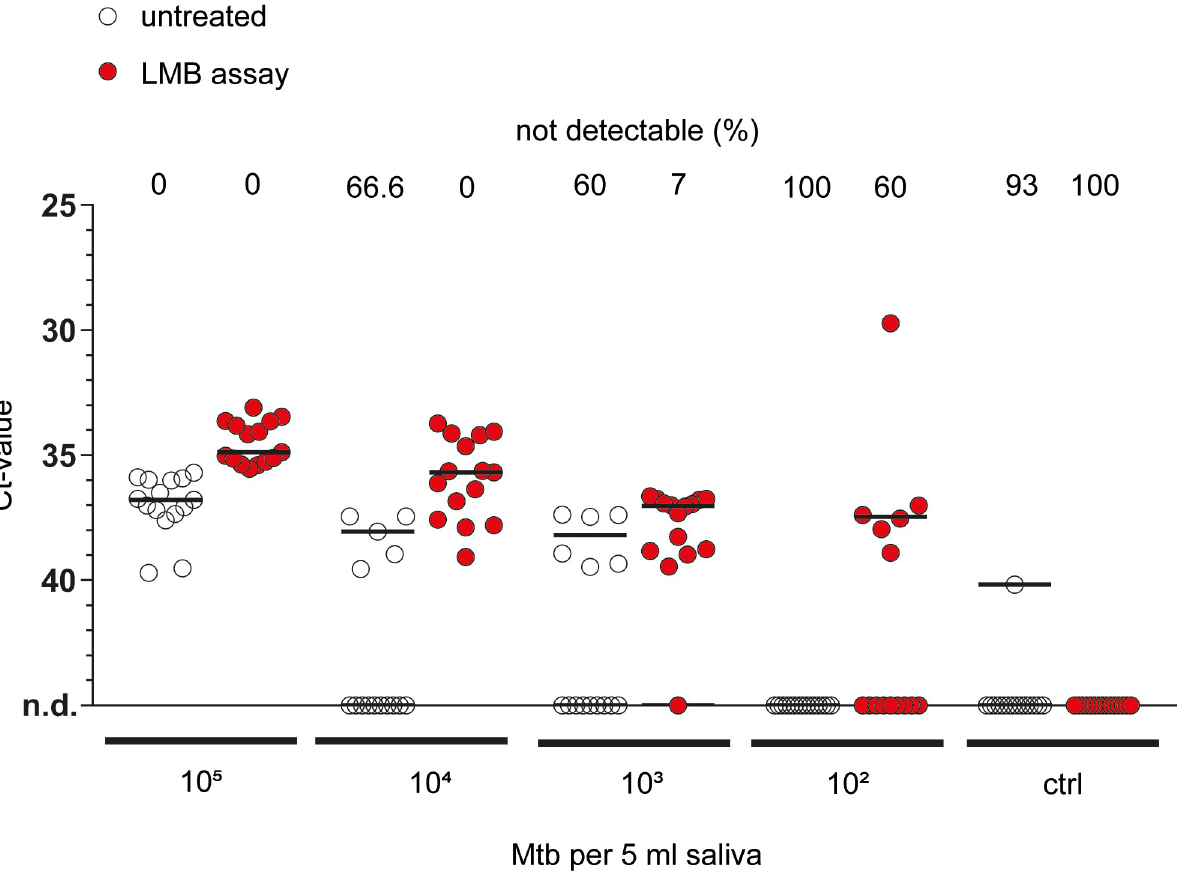
Fig 3. The effect of LMB assay on qPCR-based detection of Mtb in saliva. Saliva samples from healthy subjects were spiked with Mtb H37Rv and either left untreated or underwent pre-treatment with LMBs (LMB assay). The same volume of untreated or LMB pre-treated sample was subjected to heat treatment, DNA purification and qPCR analysis. Line at each condition indicates the median of data from five independent experiments each consisting of three technical replicates. Above each condition, the percentage (%) of samples in which no signal could be detected (not detectable, n.d.) is given. Ctrl, control, no bacteria added. A non-parametric analysis of variance for repeated measurements was used as a statistical test, which included data from all doses of bacteria (untreated vs LMB assay; p = 6.038205 x 10 − 35 ).